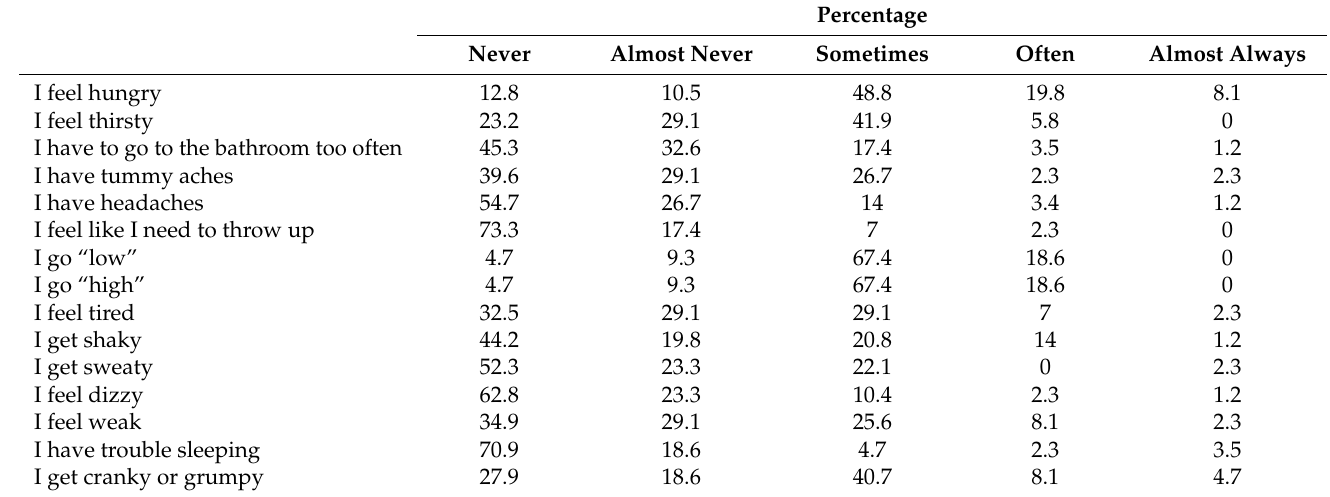
Table 4. Patients’ reports on frequency of different diabetes-related problems during the month before the research interview ( n =